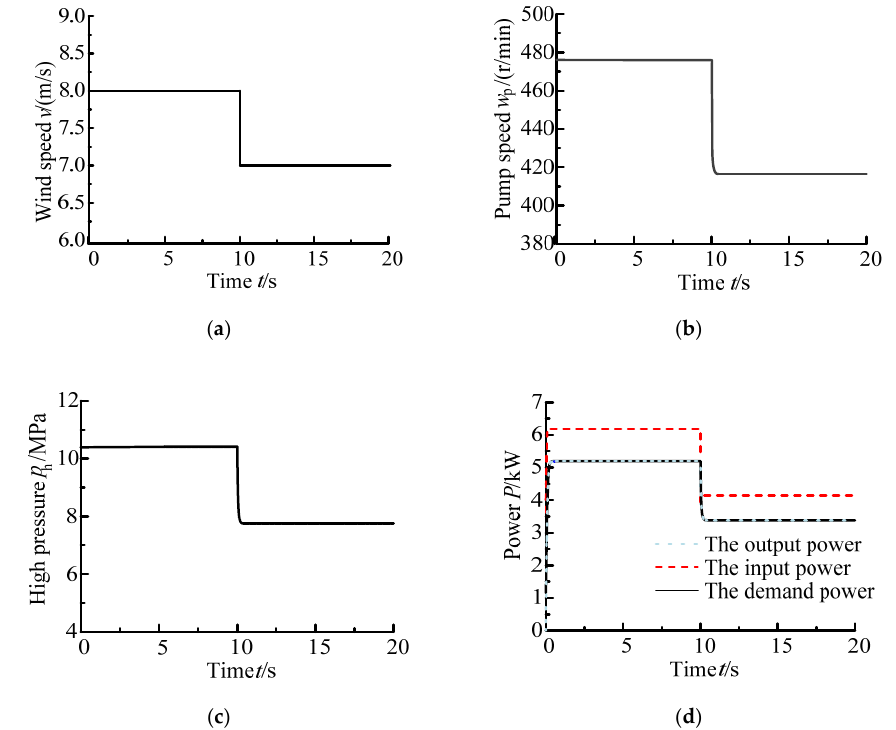
Figure 7. the response curve under the condition of 8 m/s-7 m/s step wind speed at 10 s. ( a ) the wind speed; ( b ) the pump speed; ( c ) the high pressure; ( d ) the output power. speed; ( b ) the pump speed; ( c ) the high pressure; ( d ) the output